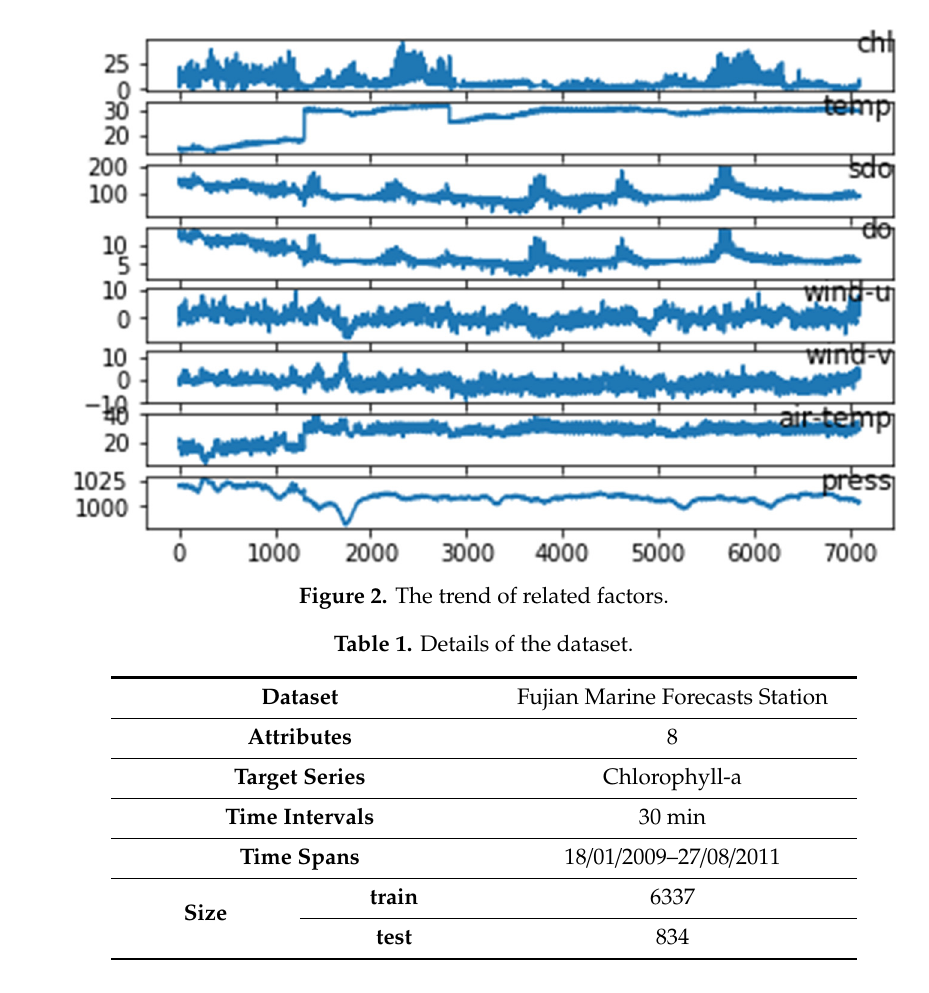
Table 2. PCC between Chl-a and related factors.